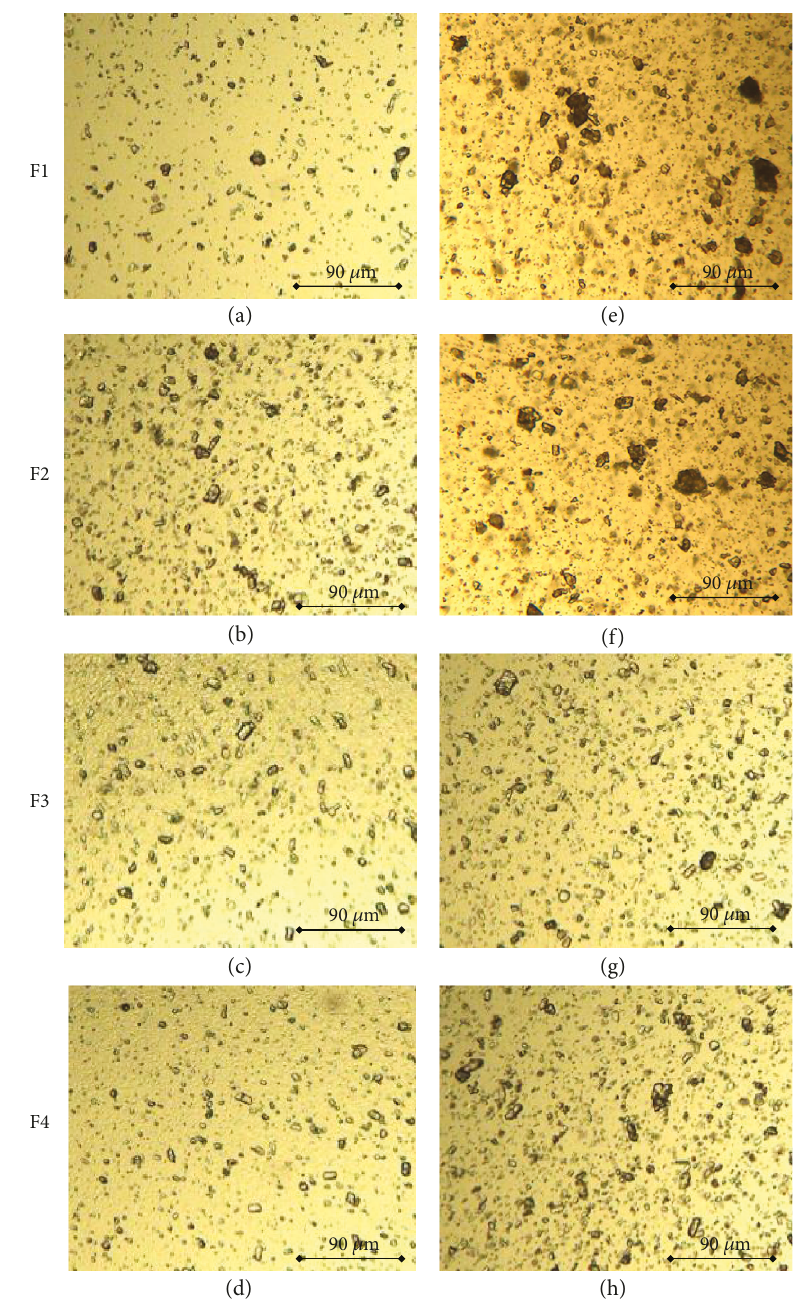
Figure 1: The optical images of hydrogels with unmodi fi ed CS (F1, F2) or with bGP-crosslinked CS (F3, F4) after preparation (a – d) and upon 3-month (F1, F2) (e – f) or 6-month storage (g – h) at refrigerated conditions (F3,